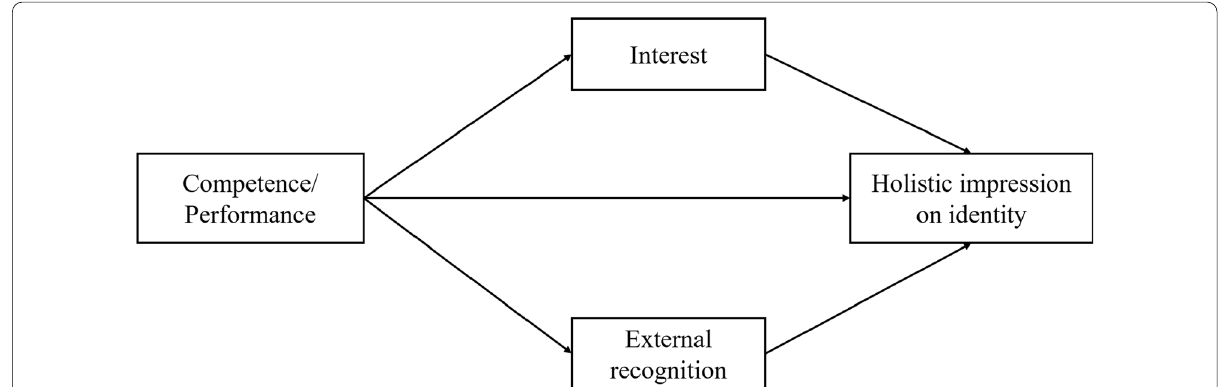
Fig. 1 The relationships between different indicators of science